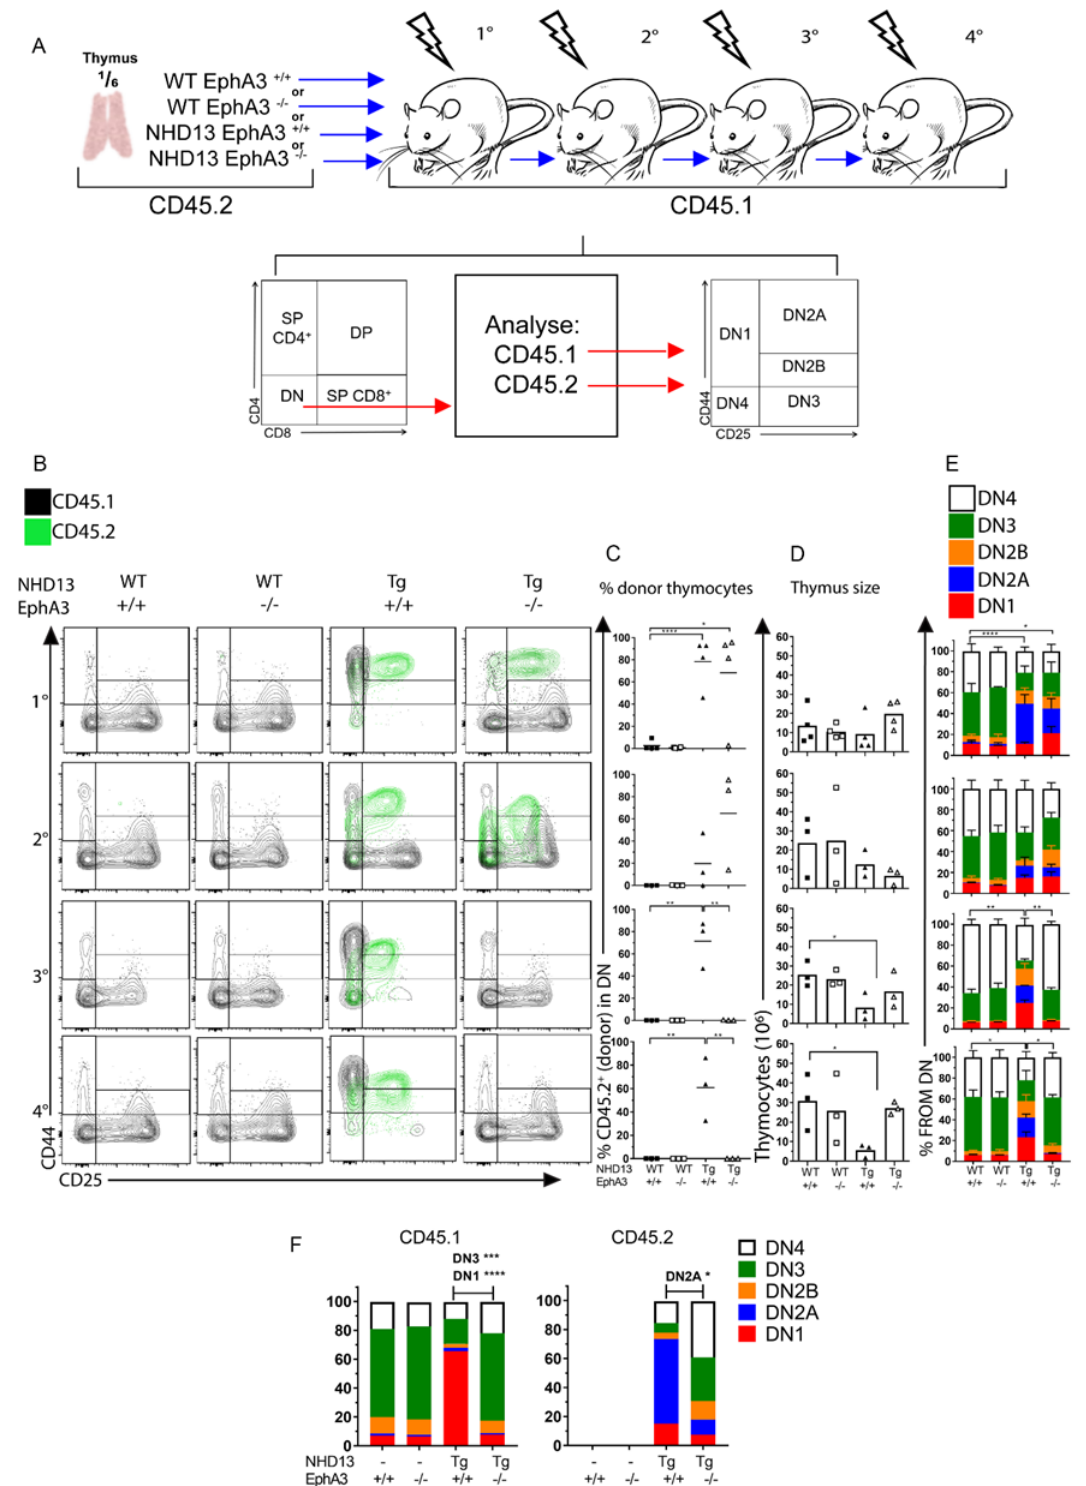
Figure 5. EphA3 prevents the normal differentiation of wild-type thymocytes in recipients, and mediates the long-term self- renewal capacity of NHD13 thymocytes upon serial transplantation. ( A ) Schematic representation of experimental design using 6-week-old donor CD45.2 thymuses from WT- EphA3 +/+ , WT- EphA3 − / − , NHD13- EphA3 +/+ , or NHD13- EphA3 − / − mice. CD45.2 thymocytes equivalent to a 1 / 6 of a thymus were IV injected into sub-lethally irradiated (6.5 Gy) C57BL/6 CD45.1 recipient mice for primary or further serial transplantations. At 4 weeks post-transplantation, engraftment and contribution of donor CD45.2 cells were analysed via flow cytometry. ( B ) Representative cell profiles of serial